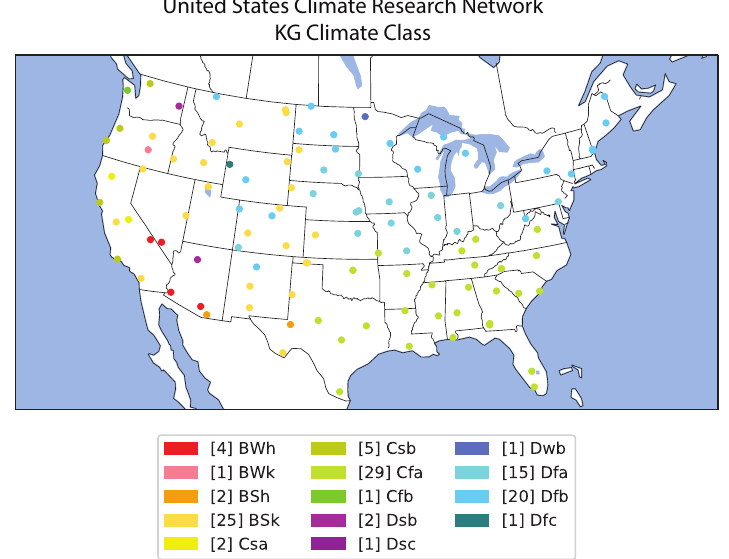
Figure 3. USCRN Soil Moisture Stations, coloured by Köppen–Geiger (KG) Climate Class. The numbers in square brackets indicate the number of occurrences of each